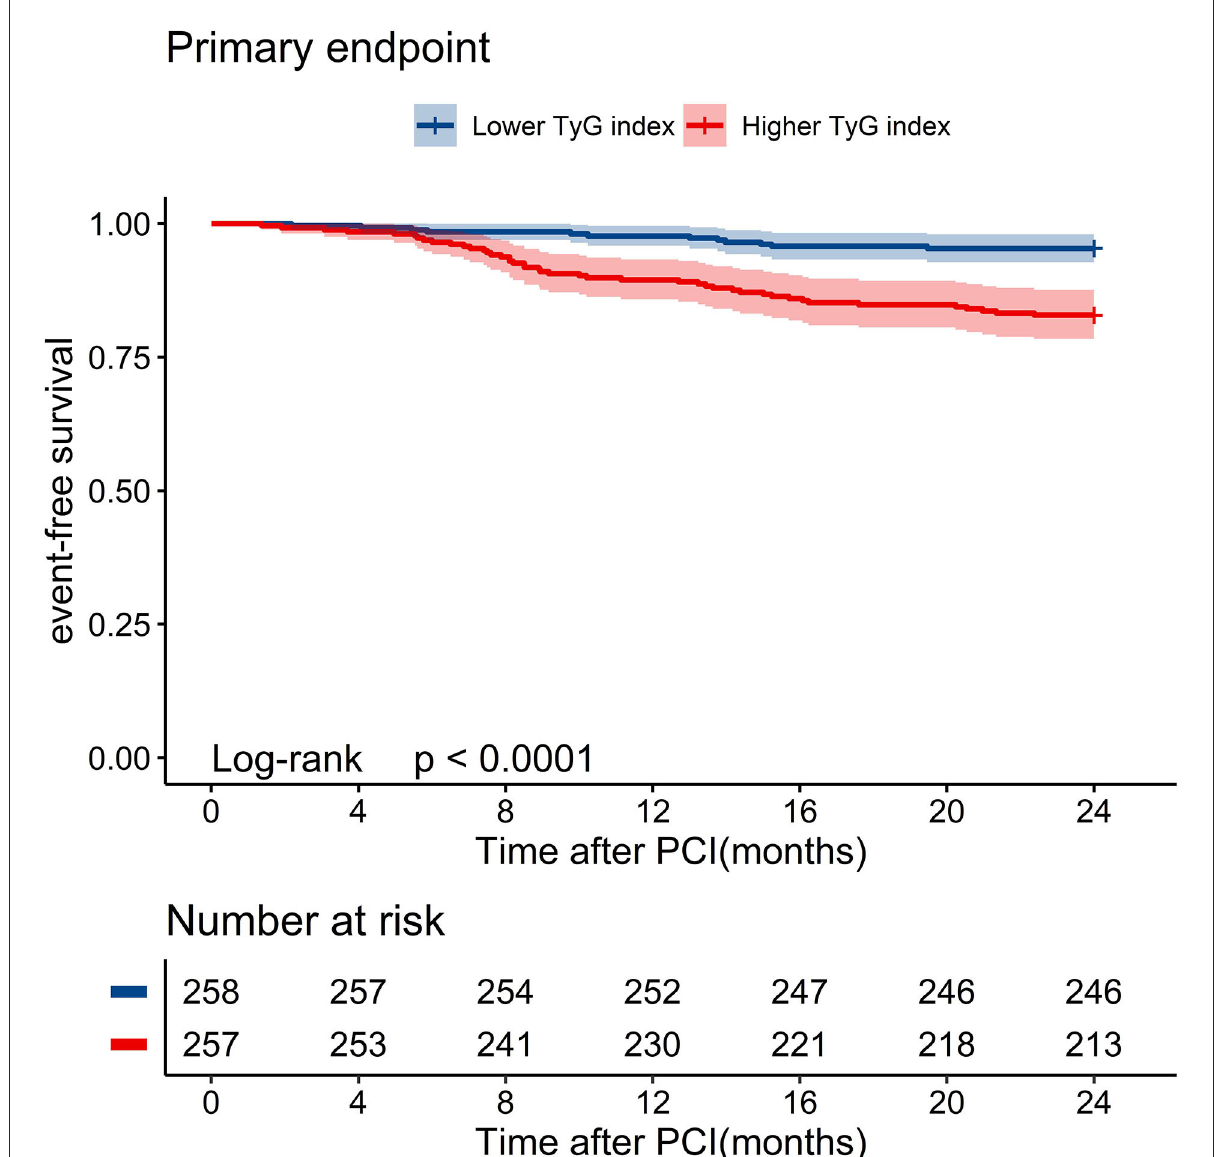
FIGURE1 Kaplan–Meier survival curves of event-free survival stratified by the median level of TyG index for 2-year primary endpoint events. PCI, percutaneous coronary intervention; TyG index, triglyceride-glucose index.